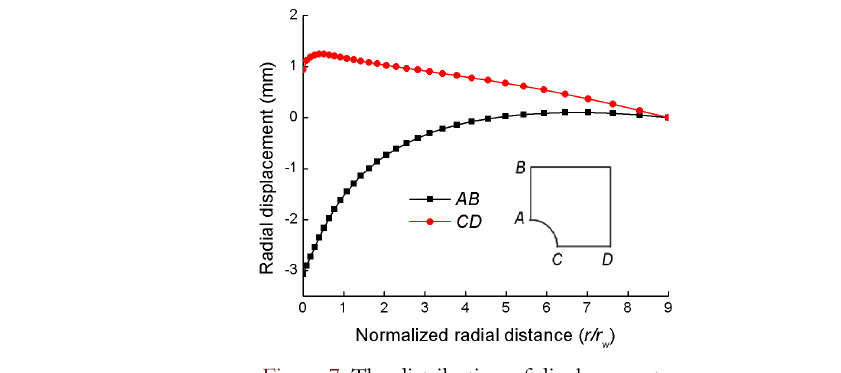
Figure 7: The distribution of displacements.